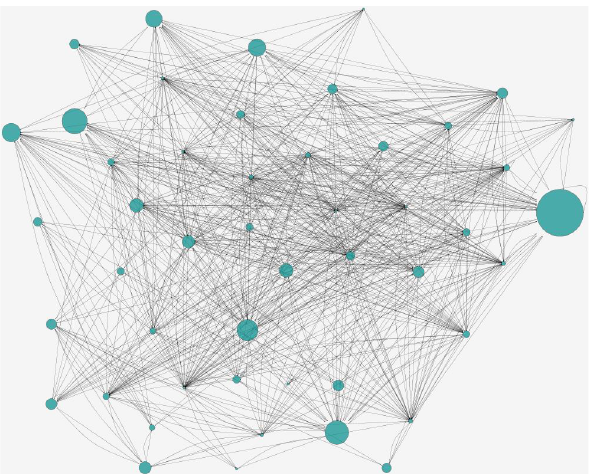
Figure 2. The food web of the Prince William Sound model (after Okey, 2004; Okey and Wright, 2004). Producers and top predators are at the bottom and at the top, respectively, according to conven- tion. Trophic groups are arranged by trophic level. The size of the nodes is proportional to the community response their disturbance generated in the simulations (Livi et al.,